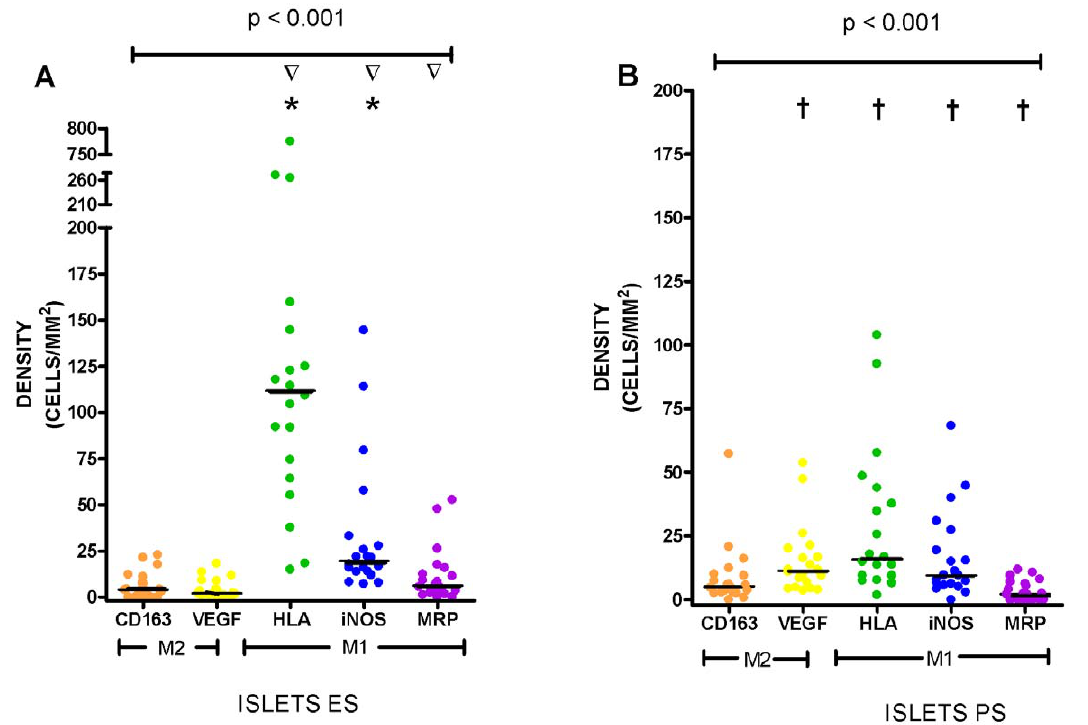
Figure 2. Non-macrophage double-stain densities in the islets in (A) extended survival (ES) and (B) poor survival (PS). * represents a significant difference (p , 0.05) in expression compared with CD163. = represents a significant difference (p , 0.05) in expression compared with VEGF. { represents a significant difference (p , 0.05) between the corresponding marker in the ES group.